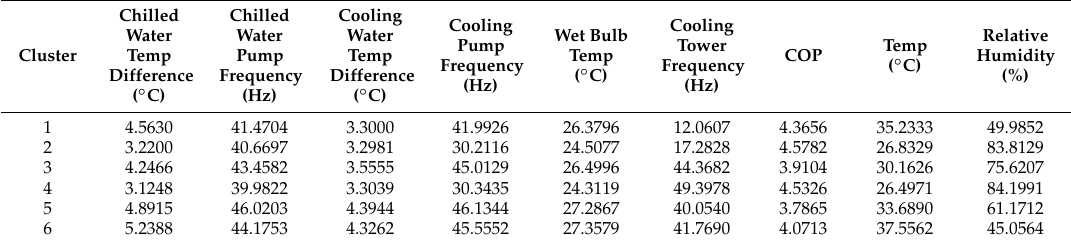
Table 3. Centroid of cluster analysis.